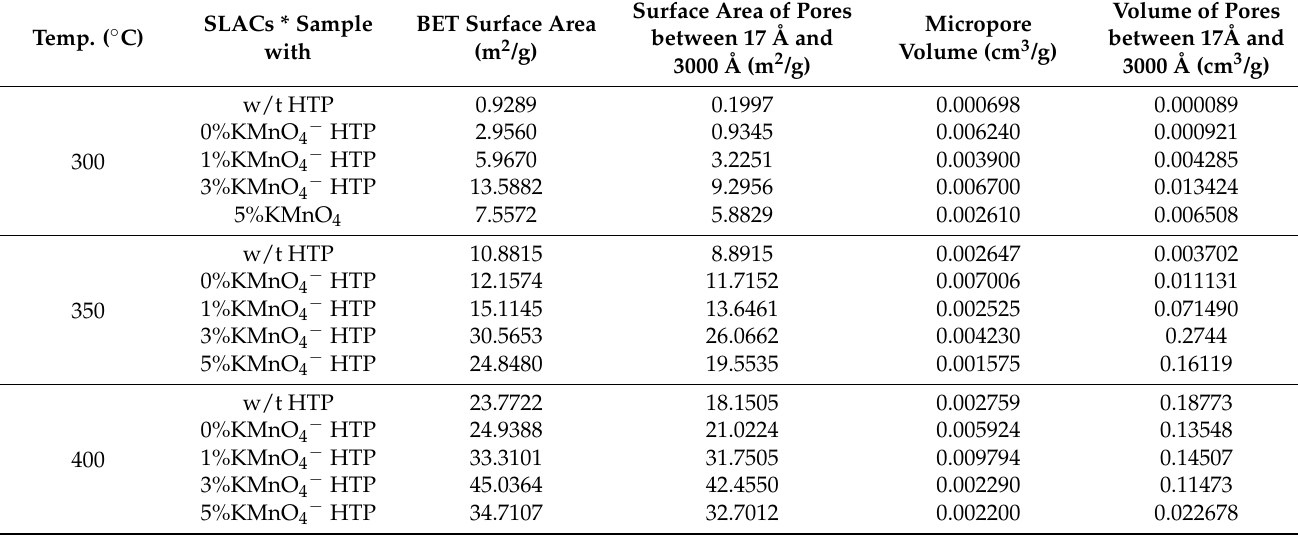
Table 2. Surface area and porosity of sugarcane leaf activated carbon determined by